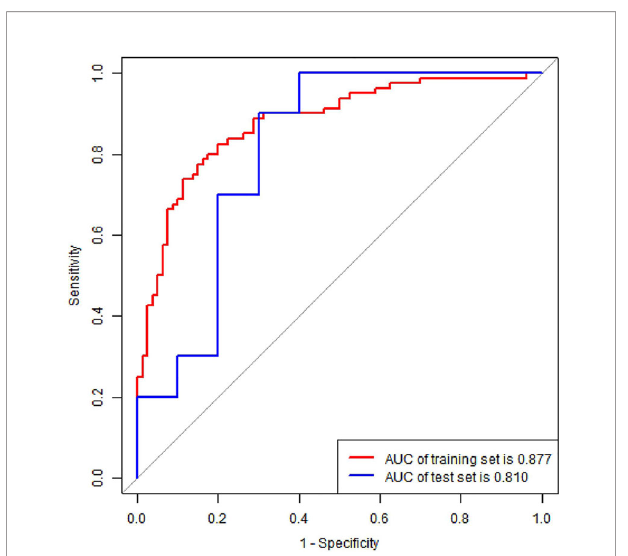
FIGURE 6 | ROC curve of radiomics nomogram in the training and validation set. AUC, area under the curve.